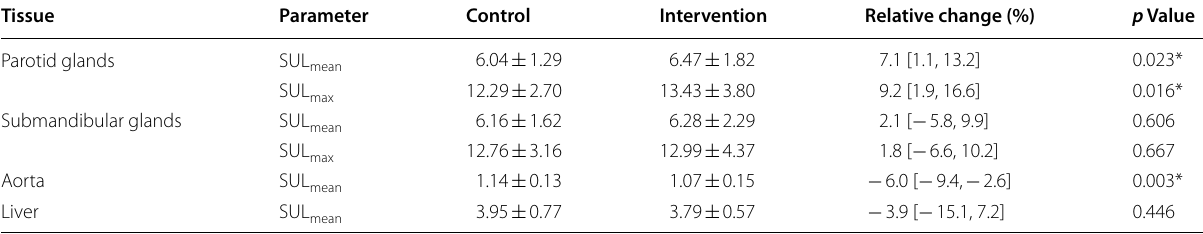
SUL, Standardised uptake value corrected for lean body mass corrected * p < 0.05 is considered statistically significant